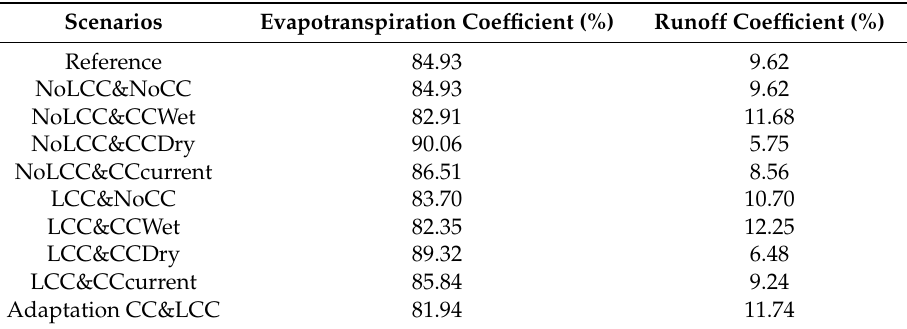
Table 5. Evapotranspiration and runoff coefficient.